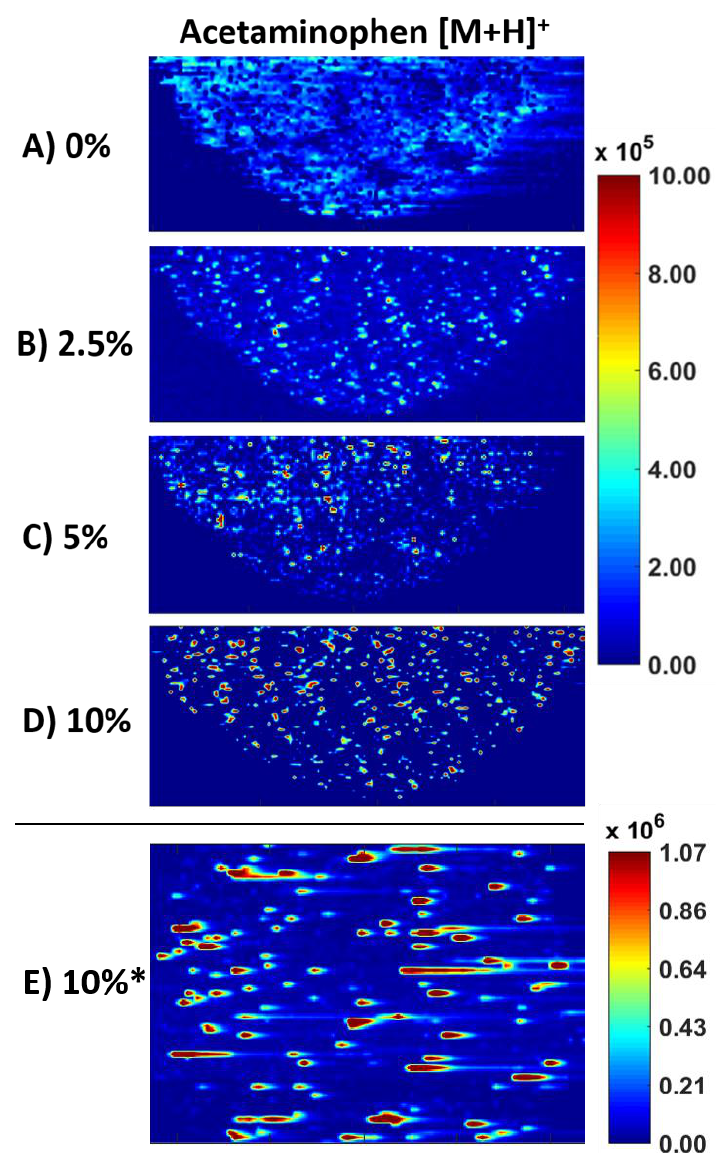
Figure 1. ELDI-MSI (electrospray laser desorption ionization mass spectrometry imaging) of standard acetaminophen tablets at increasing crystallinity percentages. Half of each pill was imaged for 1A-D with the updated method. Acetaminophen was observed at m/z 152.07 [M + H] + . Images A-D image are set to the same heatmap scaling for ease of analysis. ( A ) Image of 100% amorphous active pharmaceutical ingredient (API) tablet; ( B ) 2.5% crystalline API tablet; ( C ) 5% crystalline API tablet;